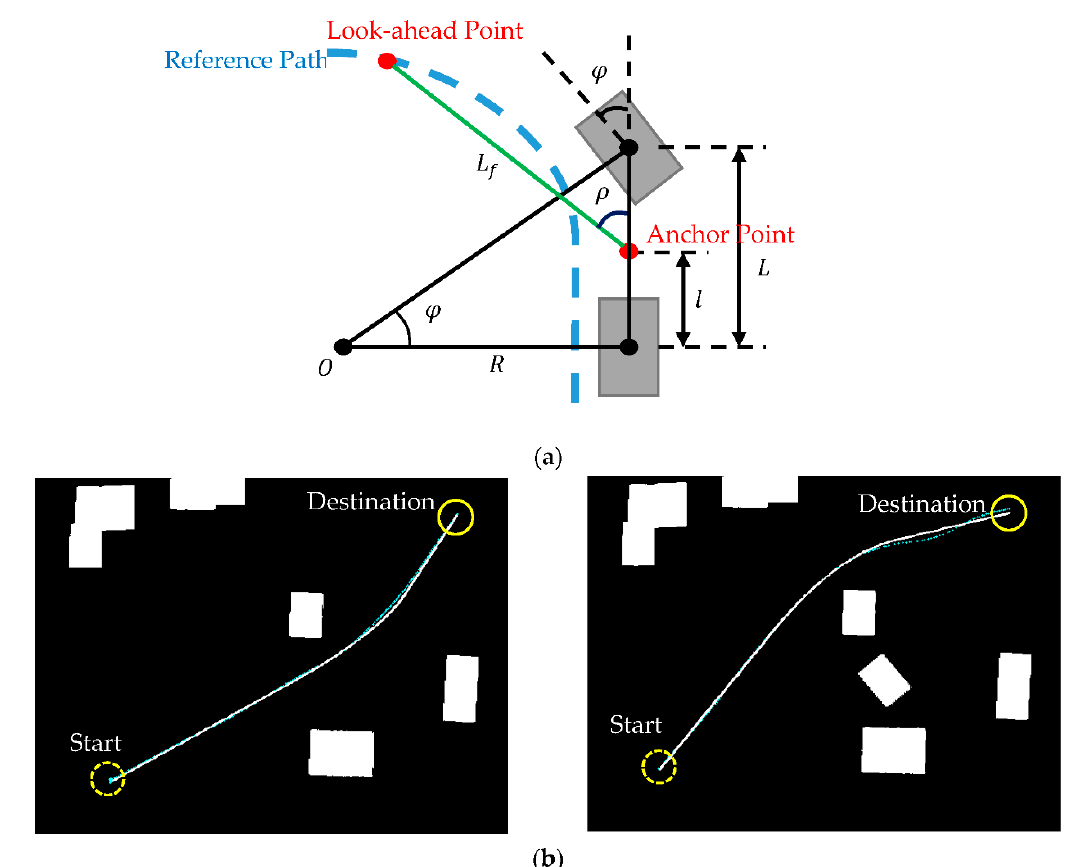
Figure 7. ( a ) The kinematic model of vehicle dynamics with the steering angle ϕ , the wheelbase L , the distance from the rear wheel axle to the forward anchor point l , the forward drive look-ahead distance L f and the heading of the look-ahead point from the forward anchor point ρ on a path with a radius of curvature R . ( b ) Experimental results of the autonomous vehicle tracking the planned path in the obstacle 1 environment (left) and the obstacle 2 environment (right), where the vehicle trajectory of the tracking control (thin line) successfully follows the path predicted by the improved RRT algorithm (solid line) in both obstacle environments.